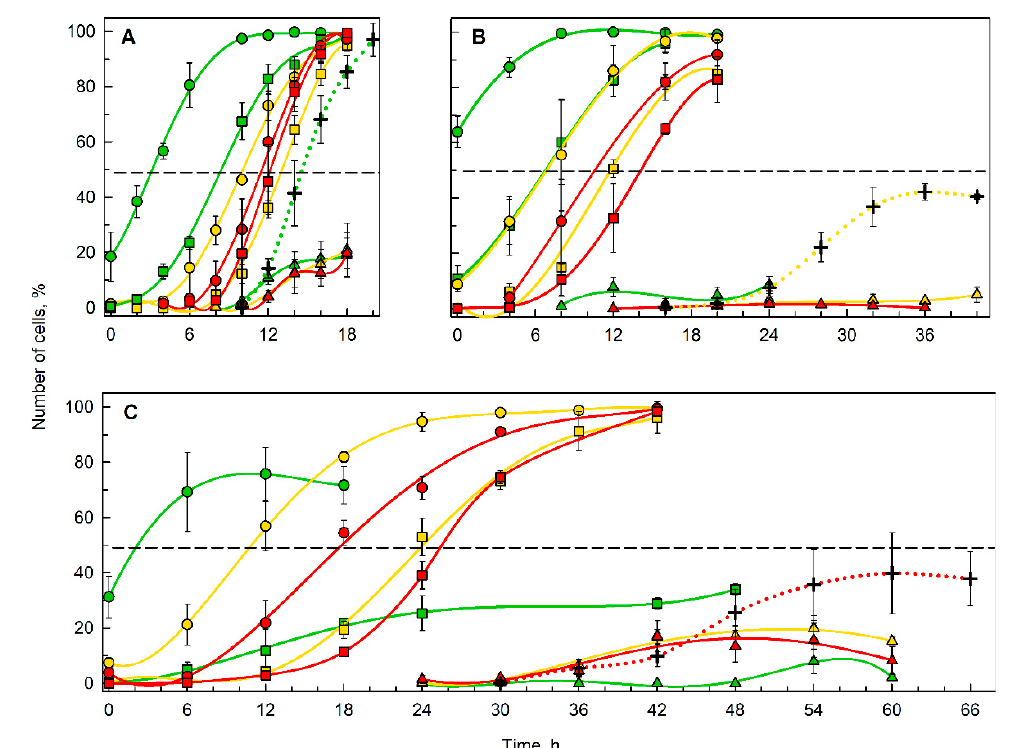
Figure 5. Percentage of cells attaining commitment point (CP) during growth in control medium with 0% D 2 O ( A ), in medium with 70% D 2 O ( B ) and in medium with 90% D 2 O ( C ). Each of the graphs shows CP attainment as the percentage of cells that finished cell division in the dark on plates with 0% D 2 O (green lines), 70% D 2 O (yellow lines) and 90% D 2 O (red lines). Attainment of the first CP (circles), the second CP (squares) and the third CP (triangles) is shown individually as analyzed from plates with 0% D 2 O, 70% D 2 O or 90% D 2 O (green, yellow and red color respectively), e.g., green circles in ( A ) represent the percentage of cells that attained their first CP after growth in 0% D 2 O and division on agar plate with 0% D 2 O. The yellow circles in ( A ) represent the percentage of cells that attained their first CP after growth in 0% D 2 O and division on an agar plate with 70% D 2 O. The green circles in ( B ) represent the percentage of cells that attained their first CP after growth in 70% D 2 O and division on agar plate with 0% D 2 O. Yellow circles in ( B ) represent the percentage of cells that attained their first CP after growth in 70% D 2 O and division on agar plate with 70% D 2 O, etc. The percentage of cells that divided during experiments in their respective growth media is represented by a green dotted line for cultures grown in 0% D 2 O ( A ), a yellow dotted line for cultures grown in 70% D 2 O ( B ), and a red dotted line for cultures grown in 90% D 2 O ( C ). The horizontal dashed line represents 50% of cells in the culture and its intersection with individual CP lines gives midpoints of CP attainment.